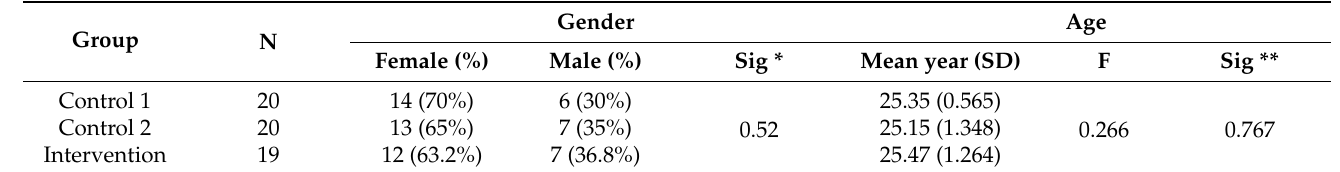
Table 1. Comparison of participants’ gender and age among the study groups.